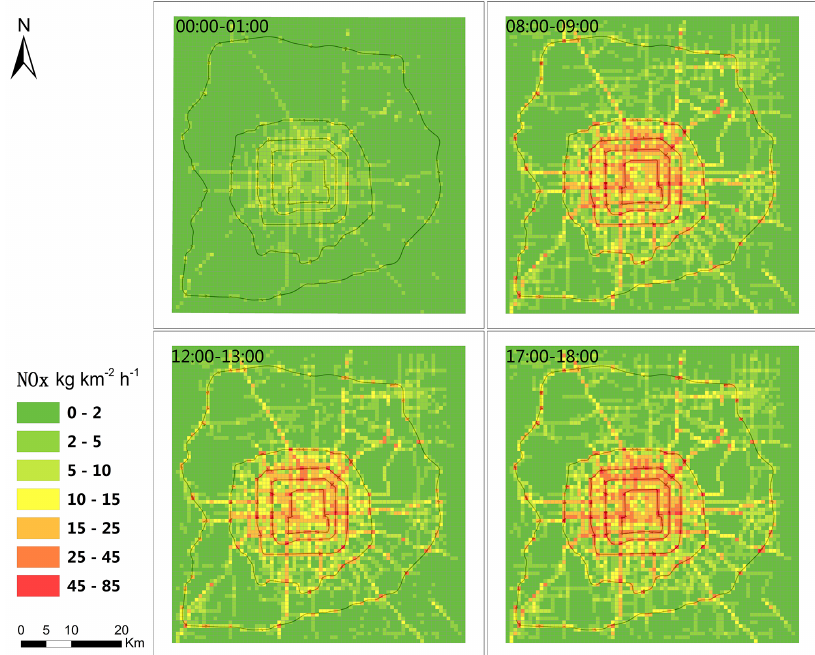
Figure 5. Grid-based vehicle emission inventory of NO x in Beijing.